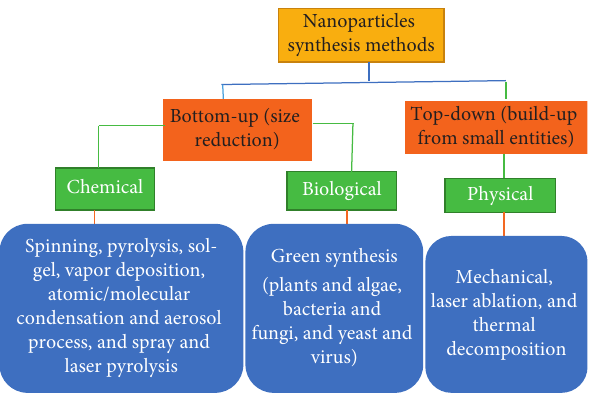
Figure 2: Synthesis methods of nanoparticles